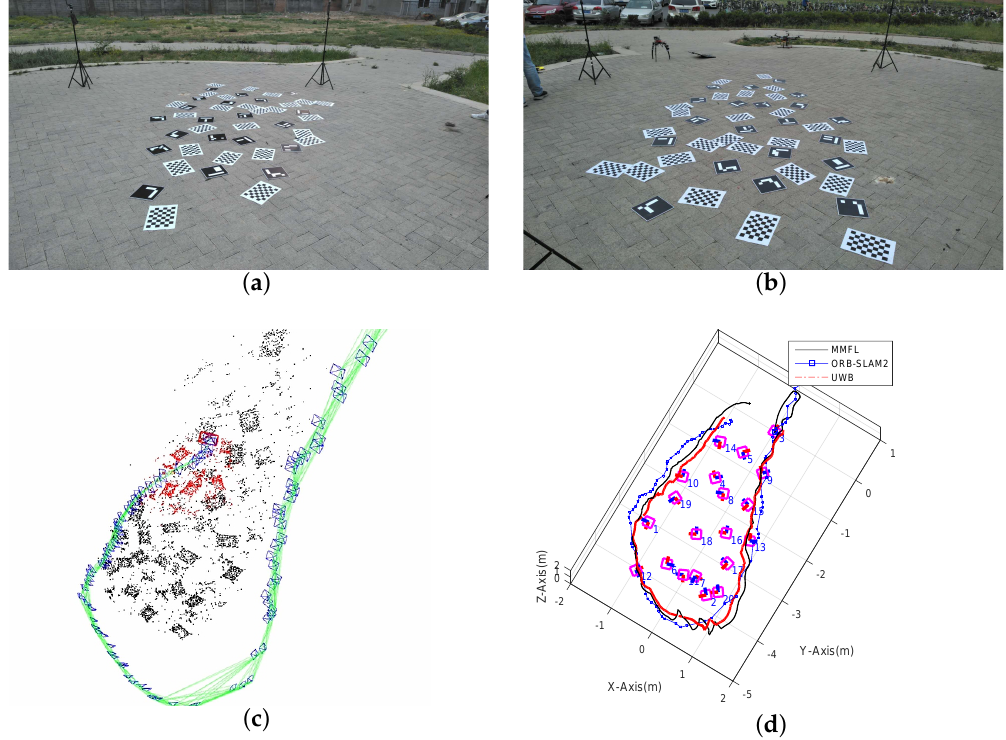
Figure 12. Results of Comparison Experiments with ORB-SLAM2. ( a ) The Front View of Experimental Site; ( b ) The Back View of Experimental Site; ( c ) 3D Reconstruction Result of ORB-SLAM2; ( d ) Estimated Camera Trajectory of Two